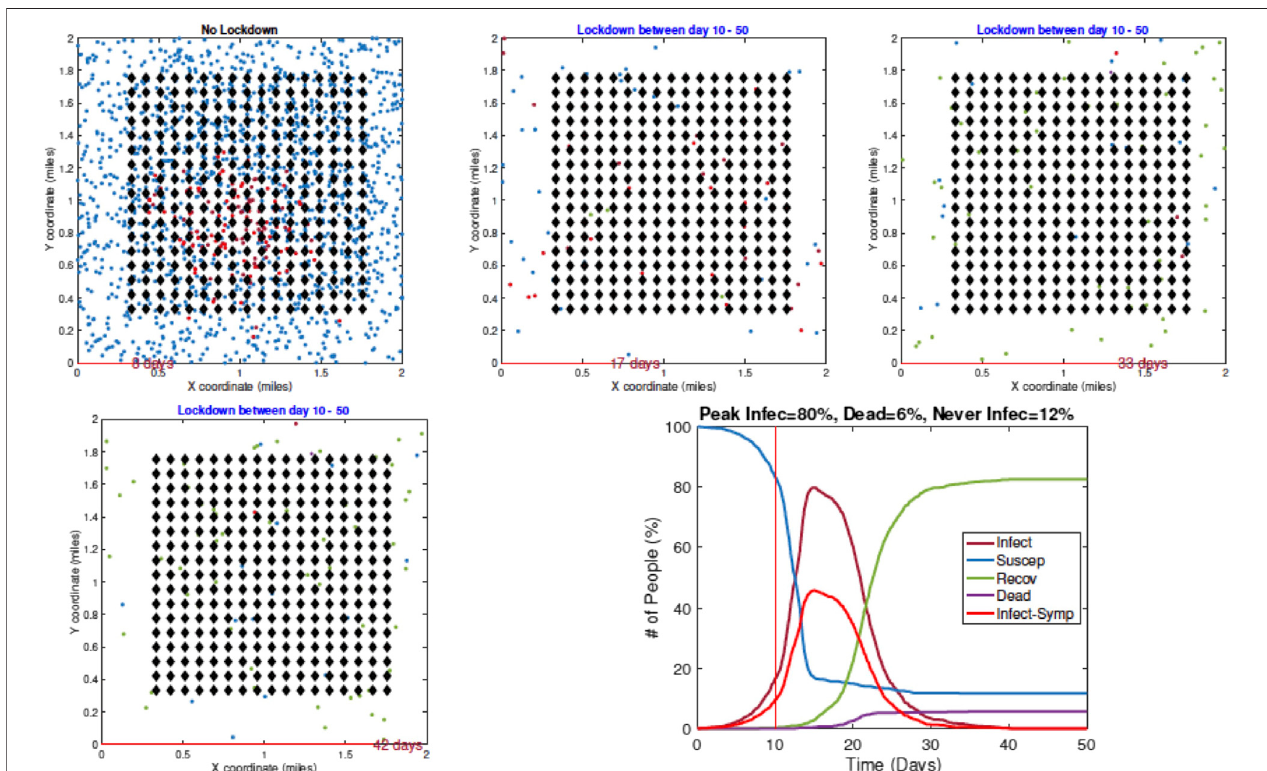
FIGURE 10 | Example 4: model outputs when a full lockdown is imposed on Day 10. The pandemic curves show that the infection has spread widely in the community by the time a lockdown is imposed.